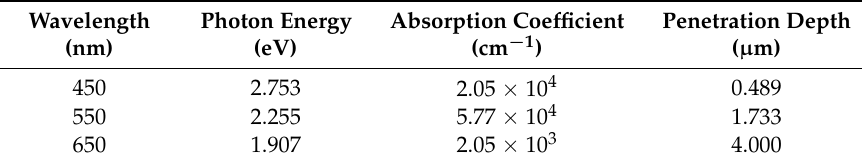
Table 1. Fundamental properties of light for a silicon crystal